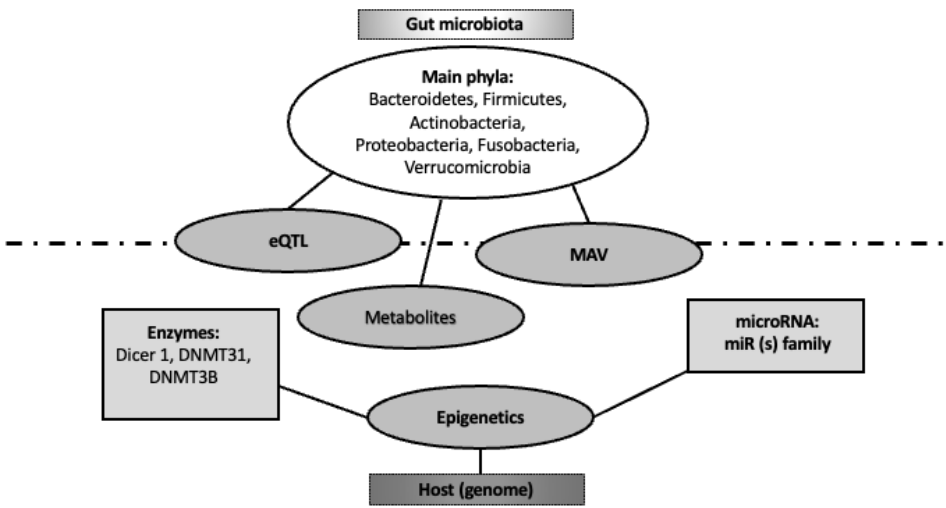
Figure 2. Bi-directional interaction between gut microbiome and human genome. The host (genome) regulates gut microbiota composition and its microbiome through several epigenetic items (namely enzymes and miRNAs). On the other hand, gut microbiome modulates host genome through its metabolites, targeting expression quantitative trait loci (eQTL) and microbiome-associated genetic variants